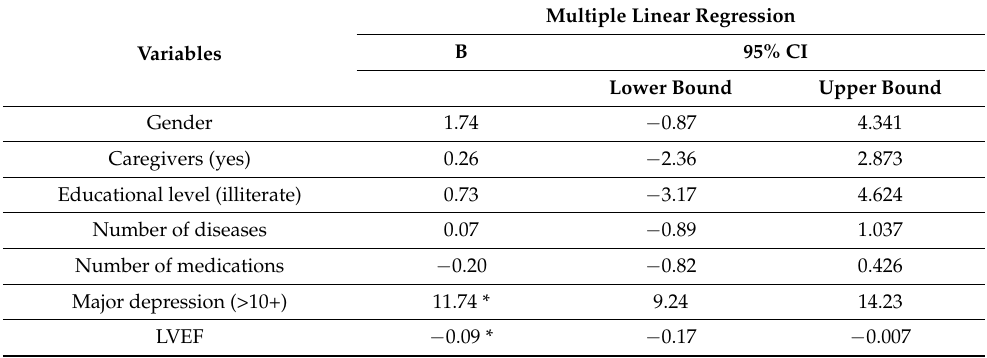
Table 4. Multiple linear regression between total symptom burden score and related